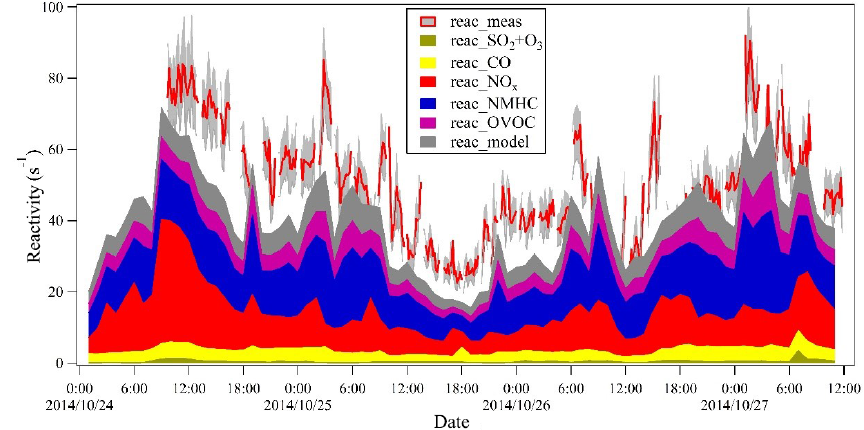
Figure 12. Comparison between measured reactivity and calculated reactivity, as well as modeled reactivity in Heshan between 24 and 27 October